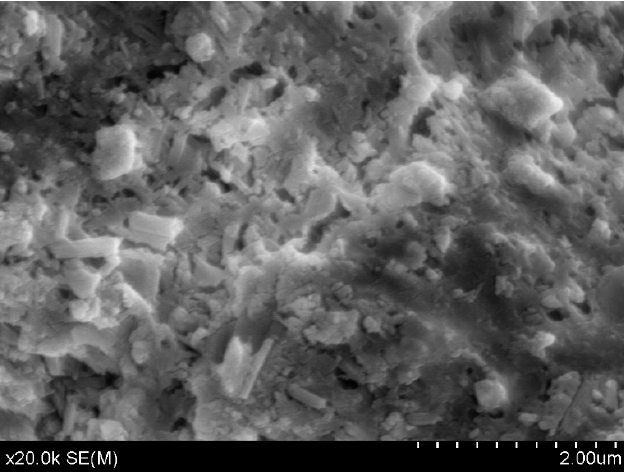
Figure 3. SEM image of the C ‐ CP unbroken sample.